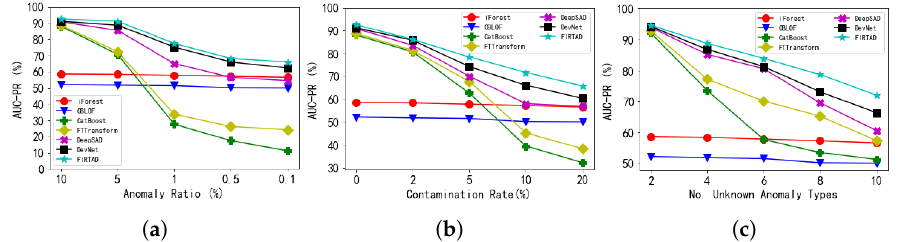
Figure 5. Test on Robustness. ( a ) Robustness with regard to anomaly ratio; ( b ) Robustness with regard to label contamination; ( c ) Robustness with regard to unknown anomalies. We find that although the unsupervised models exhibit the best robustness, their performance is limited. The supervised models suffer most from the decrease in supervised information and label quality; they perform even worse than unsupervised models. The semi-supervised models show good robustness against the anomaly ratio. However, the performance degrades significantly with respect to label contamination and unknown anomalies. Our proposed FIRTAD shows better robustness and consistently outperforms the other